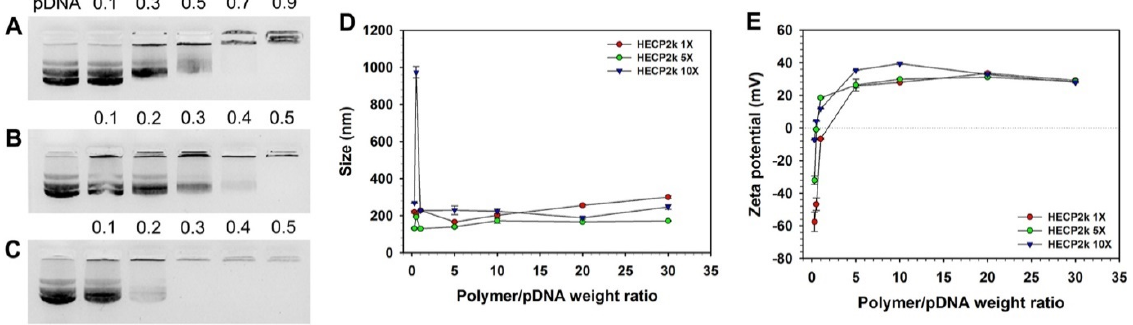
Figure 2. Agarose gel electrophoresis of ( A ) HECP2k 1X, ( B ) HECP2k 5X, and ( C ) HECP2k 10X. ( D ) Z-average size and ( E ) zeta-potential values of HECP2k/pDNA polyplexes.